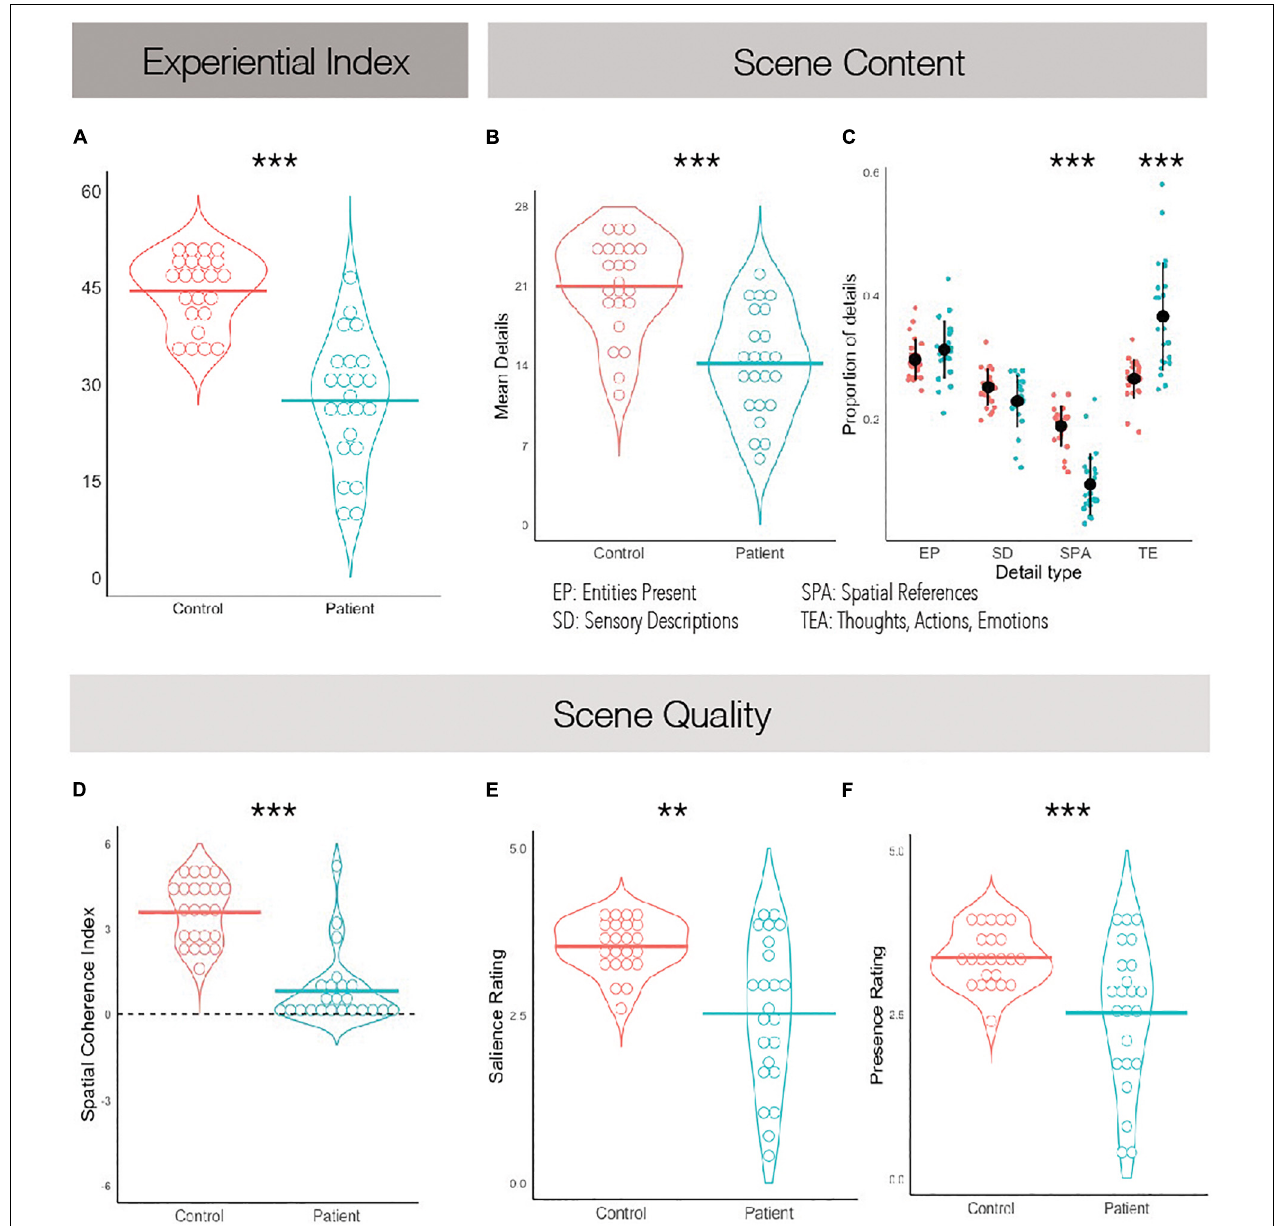
FIGURE 2 | Scene construction task performance. (A) The experiential index is a composite score summarizing scene construction ability broadly. (B) The mean detail count averaged across imagined scenes. (C) The average proportion of details imagined grouped by what kind they are. (D) The spatial coherence index, summarizing how integrated the details were within the greater imagined scene. A score of + 6 suggests a completely integrated scene and a score of − 6 suggests a completely fragmented one. (E) Average subjective ratings of salience. (F) Average subjective ratings of presence. ** p < 0.01, *** p <